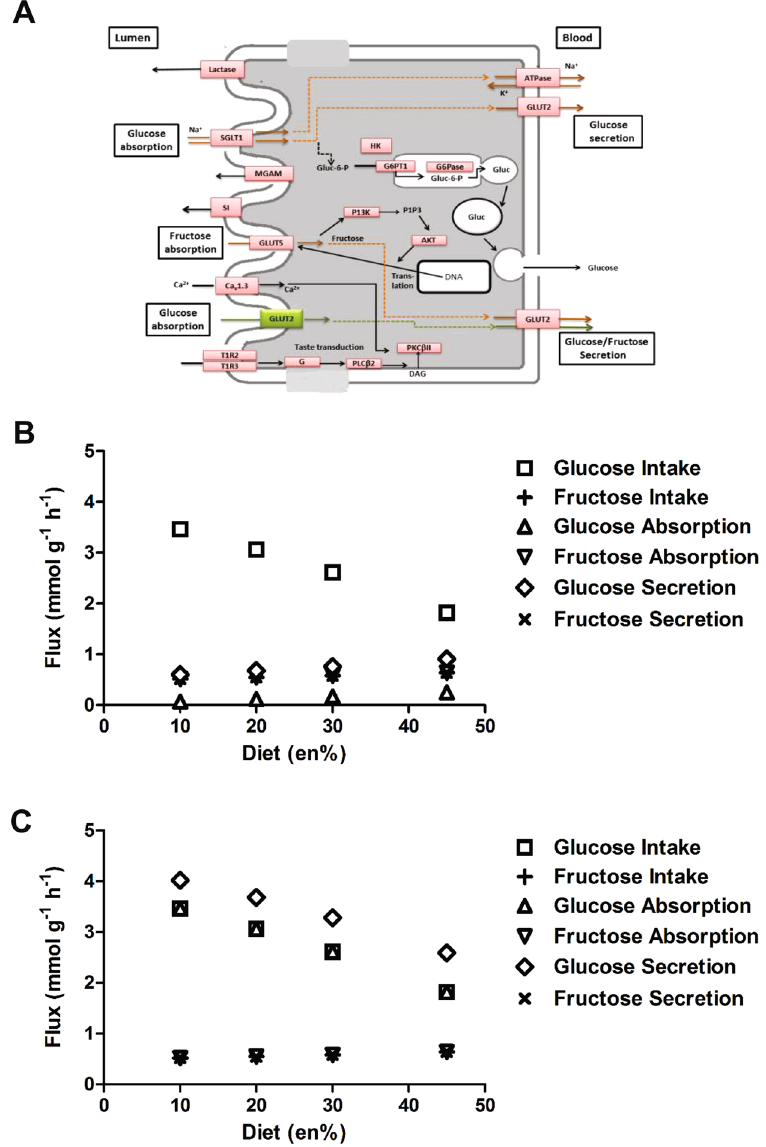
Figure 3. Carbohydrate metabolism in enterocytes. ( A ) Schematic overview of carbohydrate absorption and secretion pathways in murine enterocytes (adapted from KEGG). Apical and basolateral location of GLUT2 has been included in the graph; ( B ) Simulated maximal glucose and fructose absorption and secretion rates modelled in the absence of apically located GLUT2; ( C ) Simulated maximal glucose and fructose absorption and secretion rates modelled in the presence of apically located